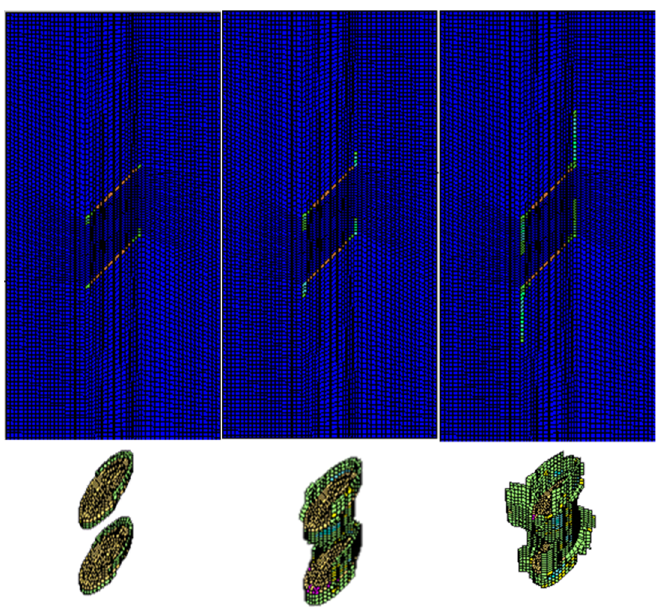
Figure 7. The fissure development and profiles of secondary